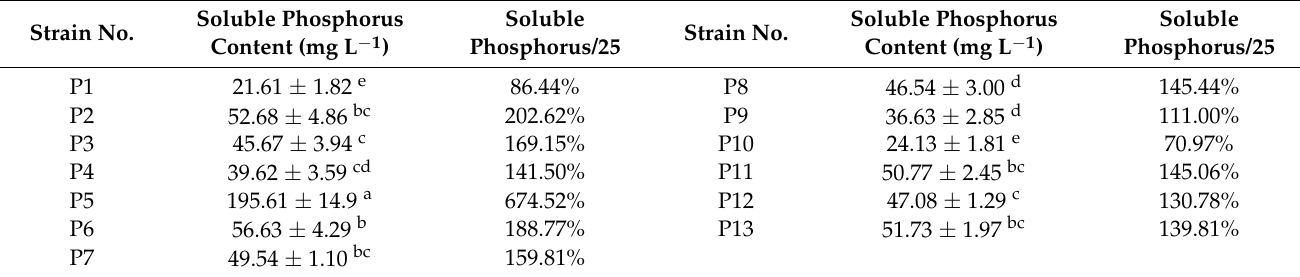
Table 2. Determination of phosphorus-dissolving ability.